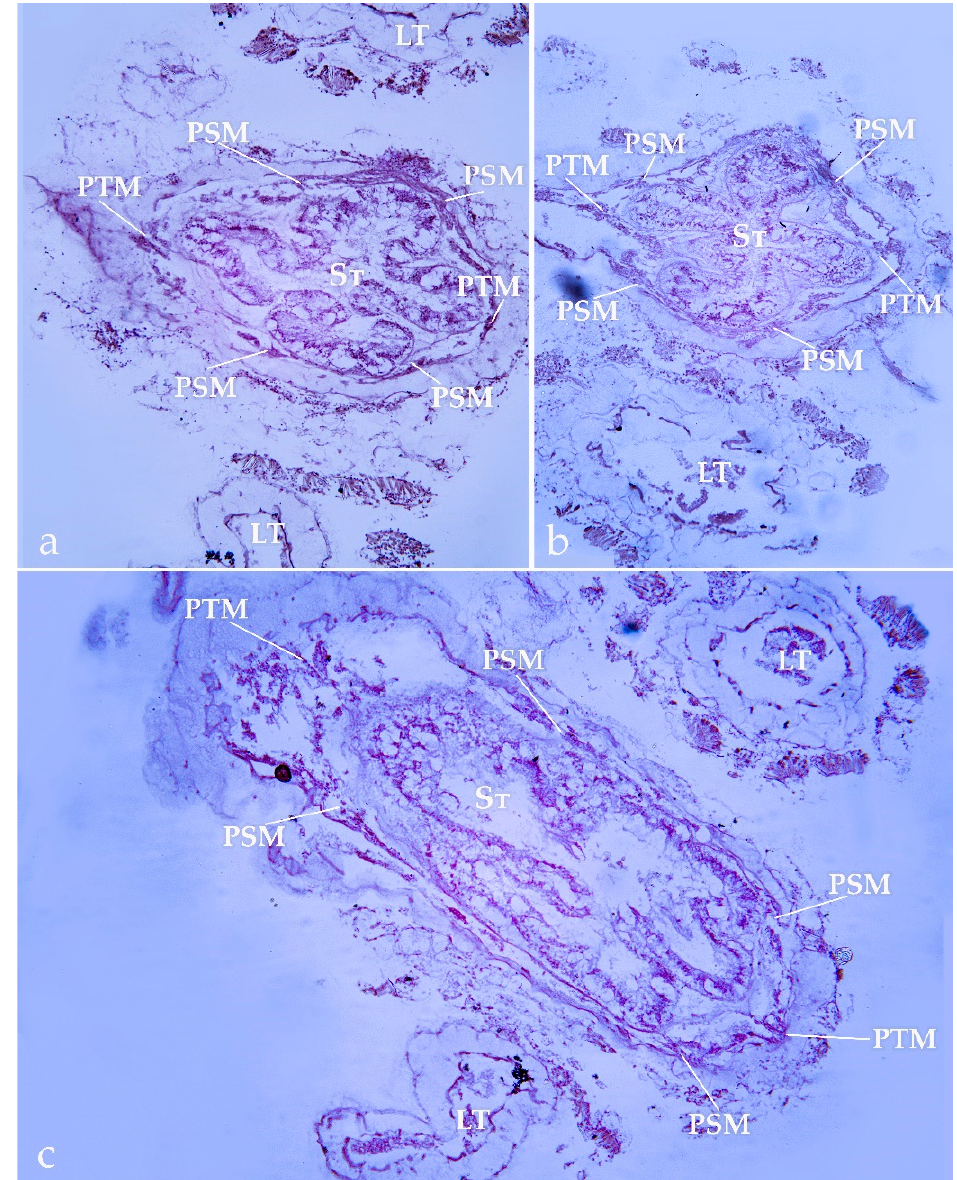
Figure 5. Histological section of polyps of Abyssopathes lyra (BPBM D2466). ( a ) cross-section of the oral cone near the base of the tentacles; ( b ) cross-section of the same polyp at the middle of the oral cone; ( c ) cross-section of another polyp at the middle of the oral cone. LT—lateral tentacle; St—stomodeum; PSM—primary sagittal mesentery; PTM—primary transversal mesentery. Scale 100 mkm.